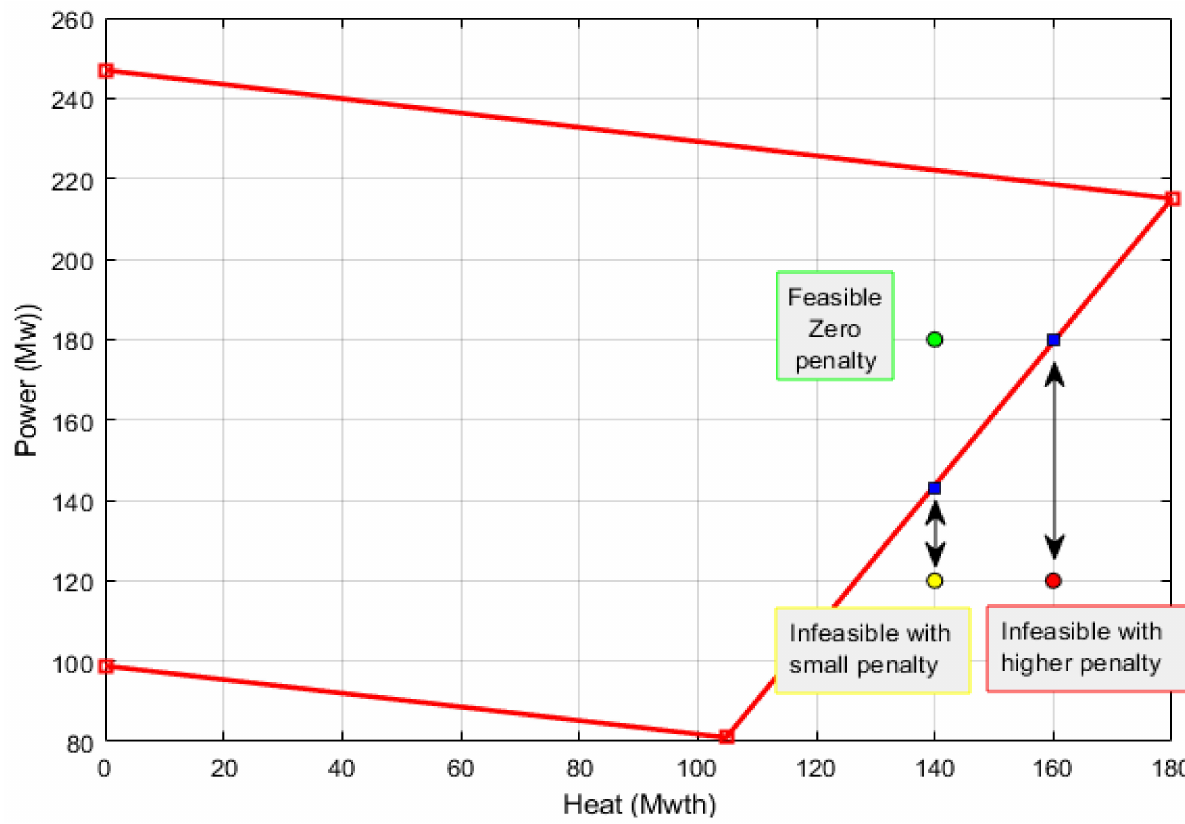
Figure 1. Permissible operating area of CHP